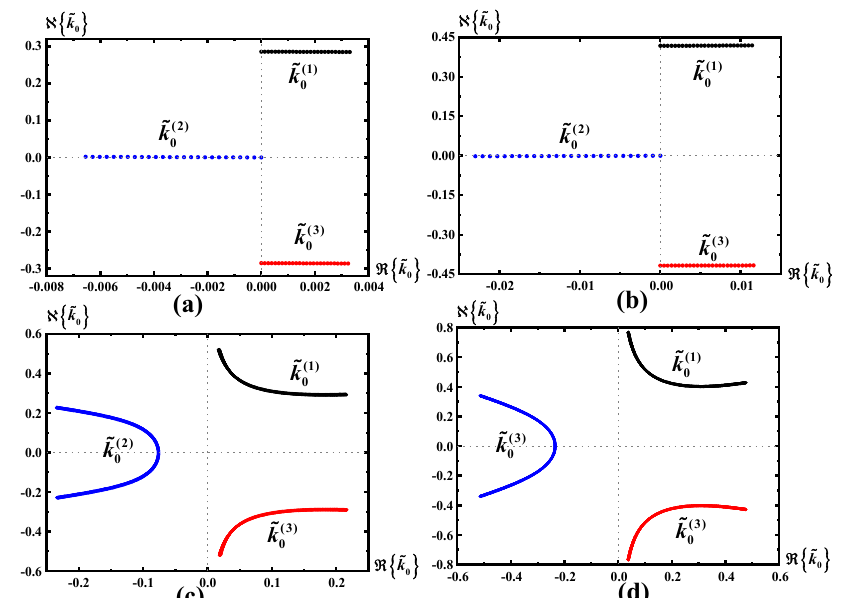
Figure 2. Figures showing the local dispersion relationship for typical cases of α − phase and β − phase , ( ∆ s < 0) with M α = 0.2, M β = 0.25, Λ α = 2.2, Λ β = 2.3, θ α = 65 ◦ , θ β = 50.55 ◦ , C ∞ = 0.01, E α = 0.1388, E β = − 0.8599. ( a ) Typical dispersion curves for the α − phase , with the real eigenvalues σ 0 = 0.0 ∼ 0.1. ( b ) Typical dispersion curves for the β − phase , with the real eigenvalues σ 0 = 0.0 ∼ 0.1. ( c ) Typical dispersion curves for the α − phase , with the complex eigenvalues σ 0 = 0.2 + i ω , where ω = − 0.1 ∼ 0.1. ( d ) Typical dispersion curves for the β − phase , with the complex eigenvalues σ 0 = 0.2 + i ω , where ω = − 0.1 − 0.1. In the figures, the black line describes 𝑘(cid:3560) (cid:2868)(cid:4666)(cid:2869)(cid:4667) , the red line describes 𝑘(cid:3560) (cid:2868)(cid:4666)(cid:2871)(cid:4667) , the blue line describes 𝑘(cid:3560) (cid:2868)(cid:4666)(cid:2870)(cid:4667) , ℜ(cid:3419)𝑘(cid:3560) (cid:2868) (cid:3423) is the real part of 𝑘(cid:3560) (cid:2868) and ℵ(cid:3419)𝑘(cid:3560) (cid:2868) (cid:3423) is the imaginary part of 𝑘(cid:3560) (cid:2868) .